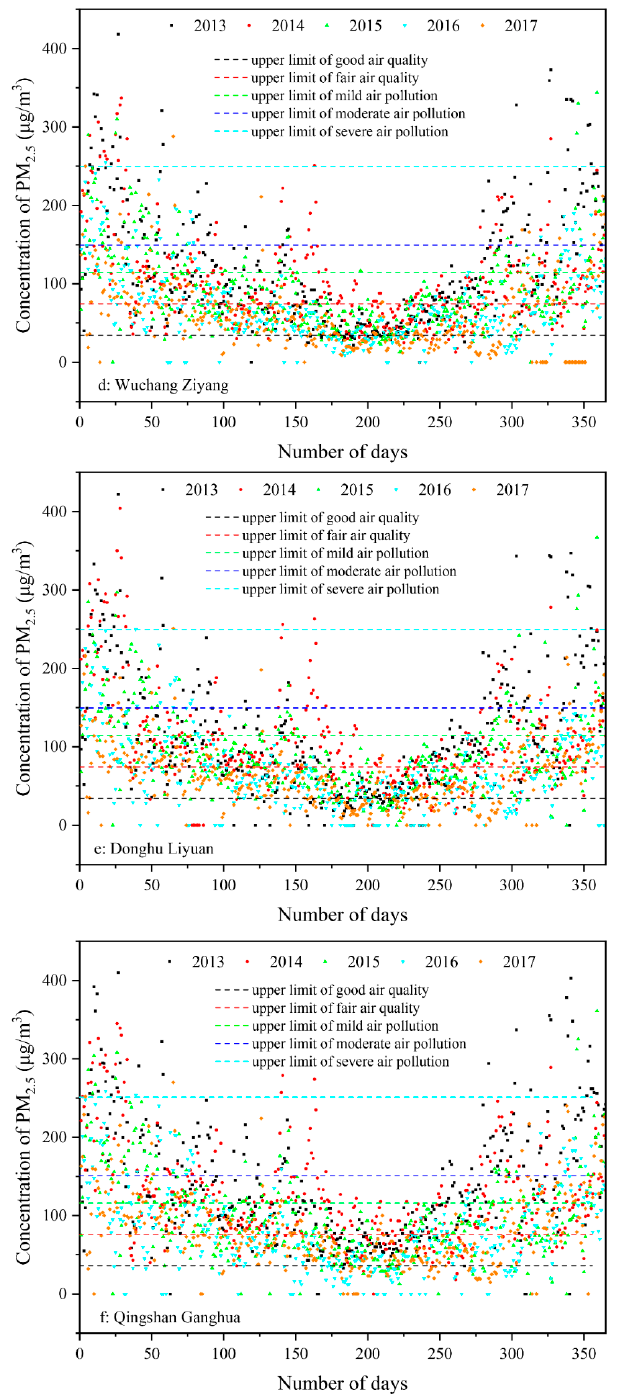
Figure 3. Annual variation trends of daily mean PM 2.5 concentration at various monitoring sites during the period of 2013–2017.